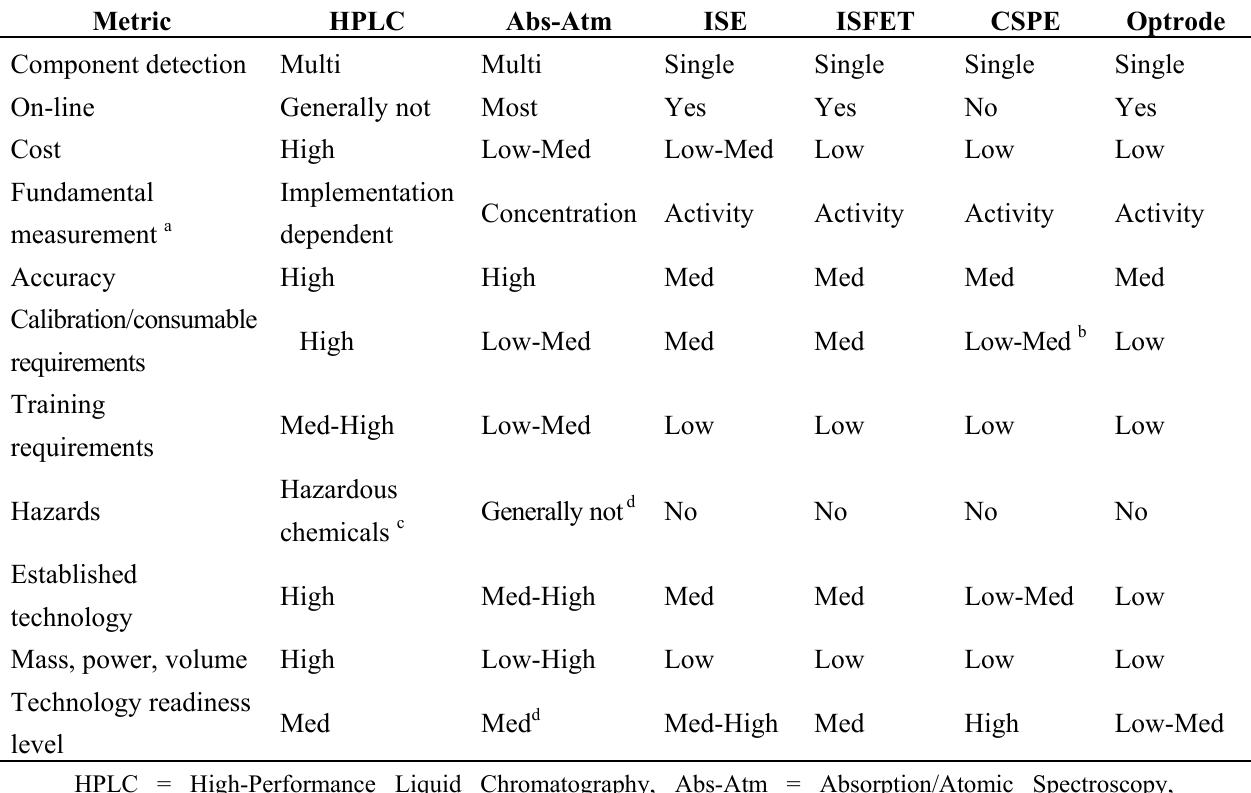
Table 2. Summary of ion-selective sensor technologies and their general performance for various considered technology